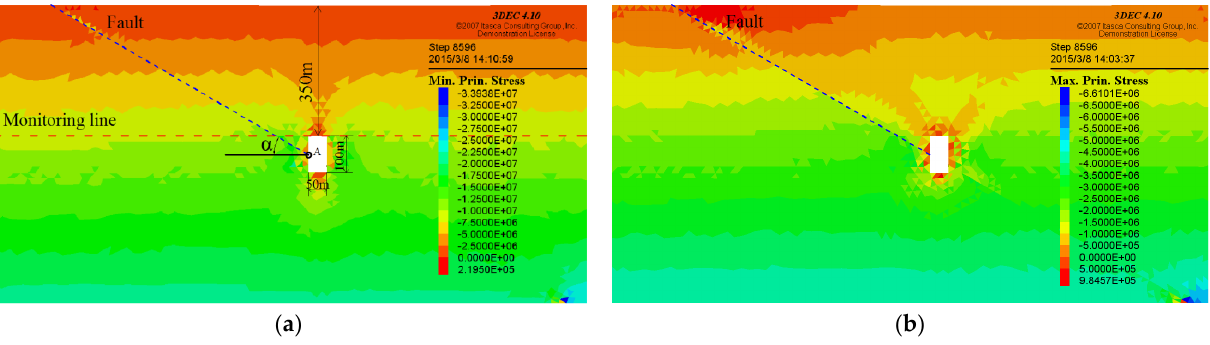
Figure 13. Stress field distribution of surrounding rock on the fault plane when the fault dip angle of 30°, they should be listed as: ( a ) Maximum principal stress distribution; ( b ) Minimum principal stress distribution.